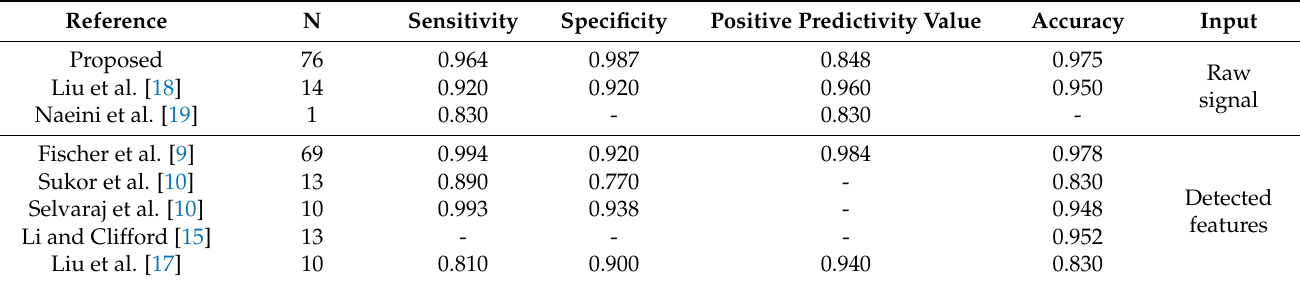
Table 5. Signal quality assessment performance compared to previous studies (N: Number of